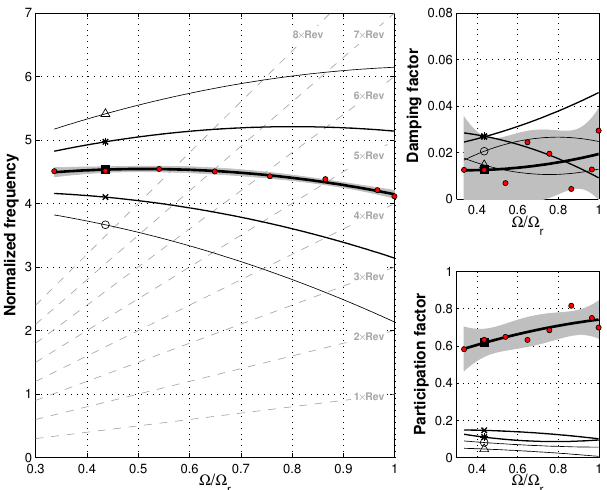
Figure 7. Periodic Campbell diagram of the first blade edgewise mode obtained from POMA